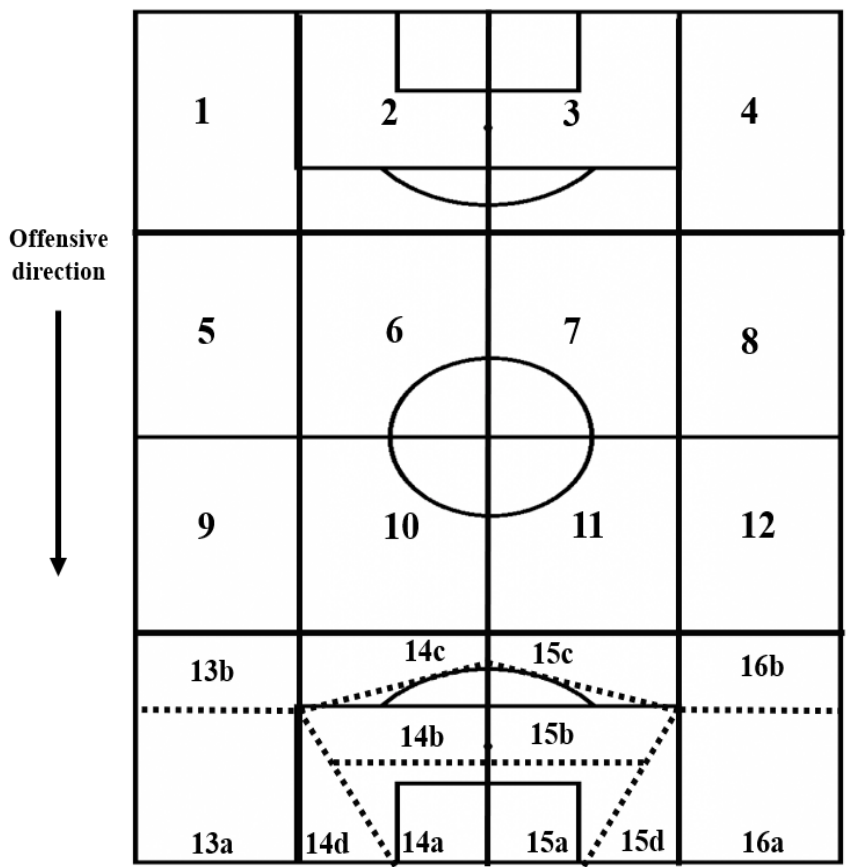
Figure 2. Zones of the field and “score pentagon”. The “score pentagon” is subdivided into several areas to perform a more detailed evaluation of goals and goal scoring opportunities.